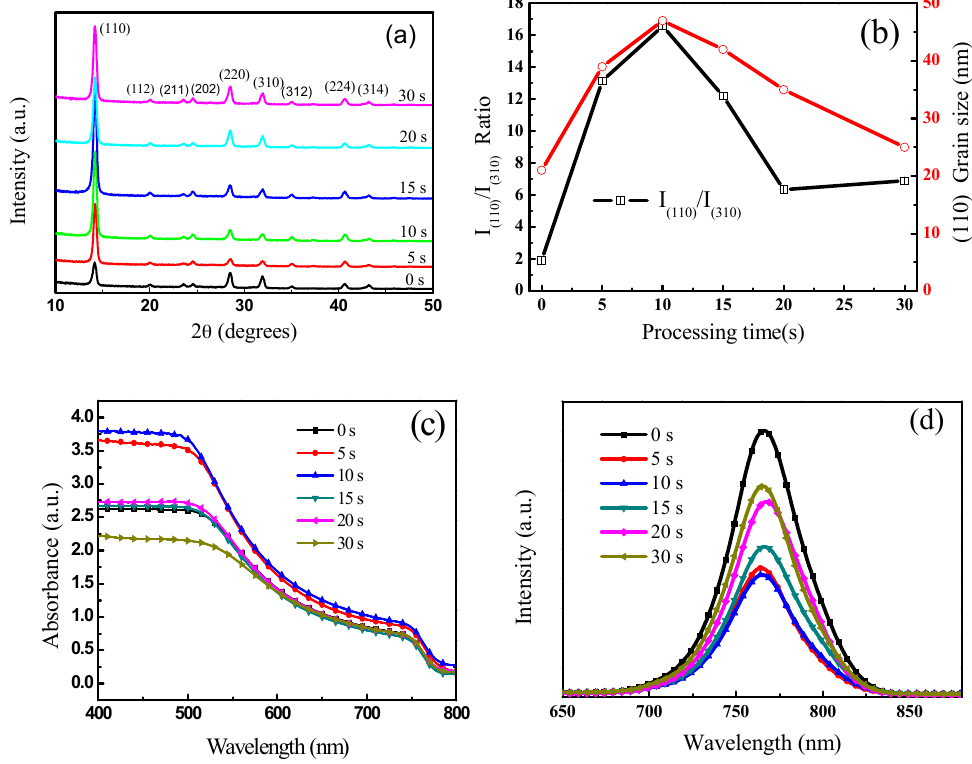
Figure 1. ( a ) X-ray diffraction (XRD) spectrum and the corresponding; ( b ) I(110)/I(310) Ratio and the average crystal size of (110) plane of the CH 3 NH 3 PbI 3 (MAPbI 3 ) films at different CH 3 NH 2 (MA) treatment times; ( c ) UV–Vis absorption spectra of MAPbI 3 films; and ( d ) photoluminescence (PL) spectrum of FTO/TiO 2 /MAPbI 3 with different times of MA treatment.